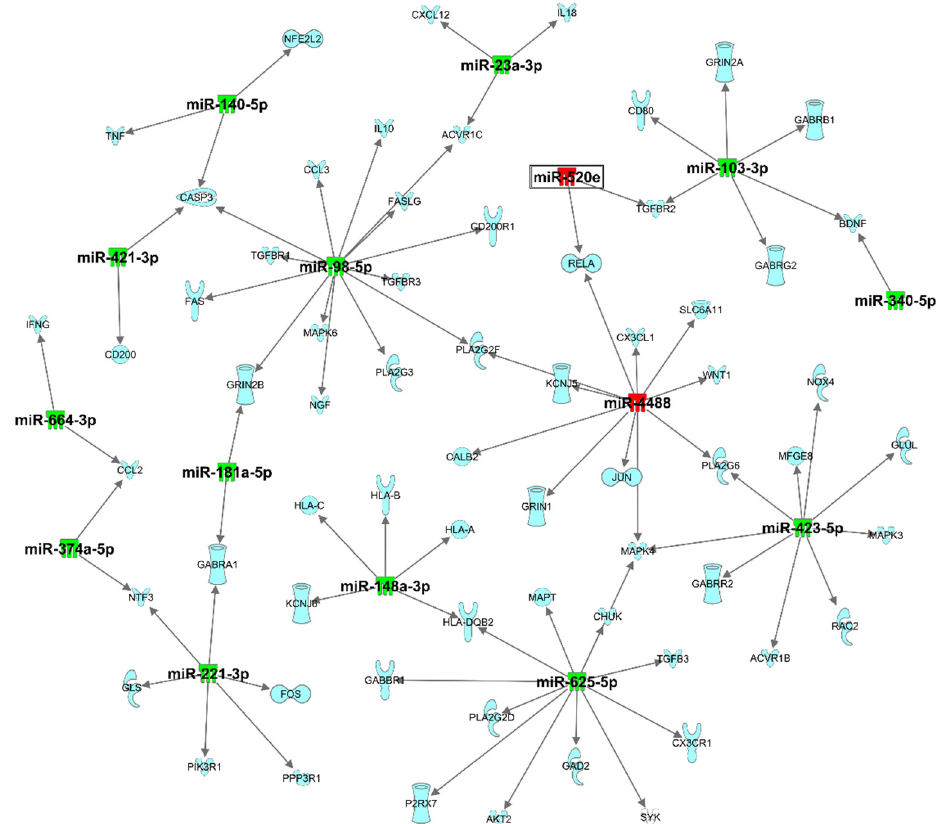
Figure 2. Target filter analysis of dysregulated exomiRNA targeting mRNA associated with neuroinflammation pathways. Green indicates genes that are downregulated, and red indicates genes that are upregulated, where increased color saturation represents more extreme down- or upregulated in the dataset. Reprinted from Ingenuity Pathway Analysis under a CC BY 4.0 license, with permission from QIAGEN Silicon Valley, original copyright 2000-2021.